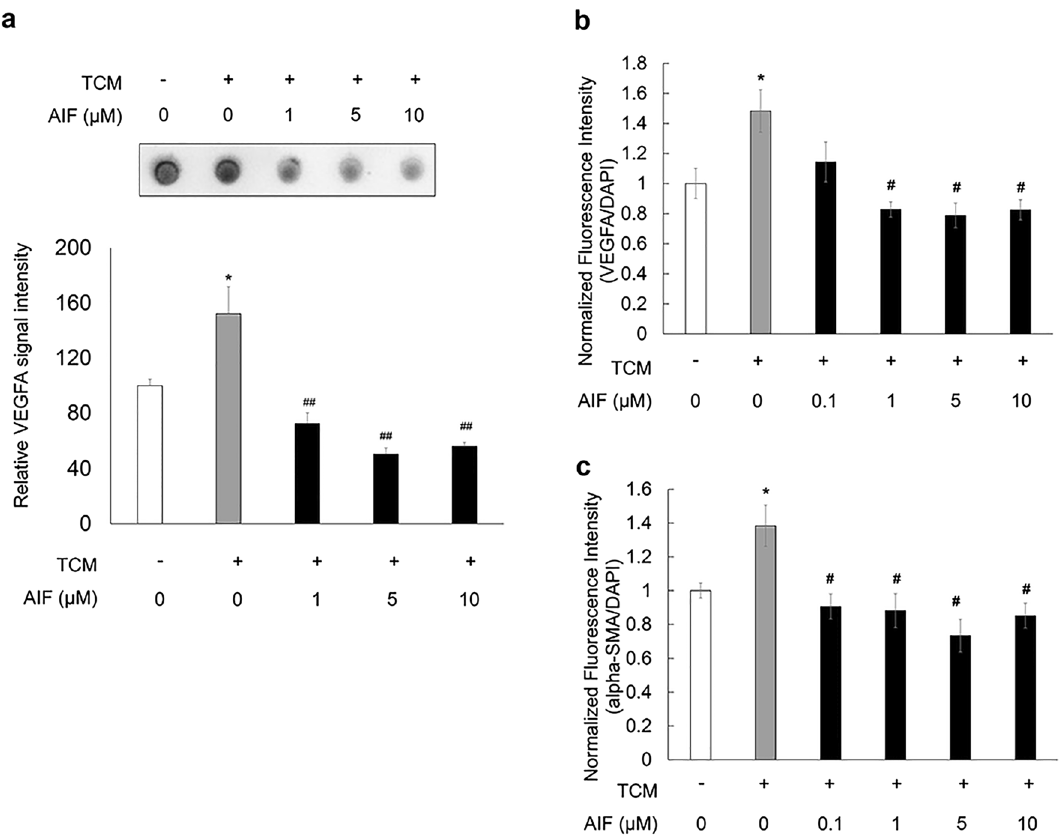
Figure 1. Inhibitory effects of alpinumisoflavone (AIF) on THP-1 conditioned media (TCM)-induced expression of vascular endothelial growth factor A (VEGFA) in ARPE-19 cells. ( a ) ARPE-19 cells were treated with 0.1% DMSO in RPMI-1640 complete media or AIF (0, 1, 5, or 10 µM) in TCM. VEGFA expression was measured by dot blot. The data were analysed using one-way ANOVA followed by the Holm-Šídák post-hoc t-test (* p < 0.05 vs. non-TCM group, ## p < 0.01 vs. cells treated with only TCM group) and are expressed as mean ± S.E. (n = 3–6). Uncropped blot images are presented in supplementary information (Supplementary Fig. 2). ( b , c ) ARPE-19 cells were treated with 0.1% DMSO in RPMI-1640 complete media or AIF (0, 0.1, 1, 5, or 10 µM) in TCM. The fluorescence intensity was measured using the FlexStation 3 Multi-Mode Microplate Reader. Data were analysed using one-way ANOVA followed by the Holm-Šídák post-hoc t-test test (*p < 0.05 vs. non-TCM group, #p < 0.05 vs. cells treated with only TCM group) and are expressed as the mean ± S.E. (n =